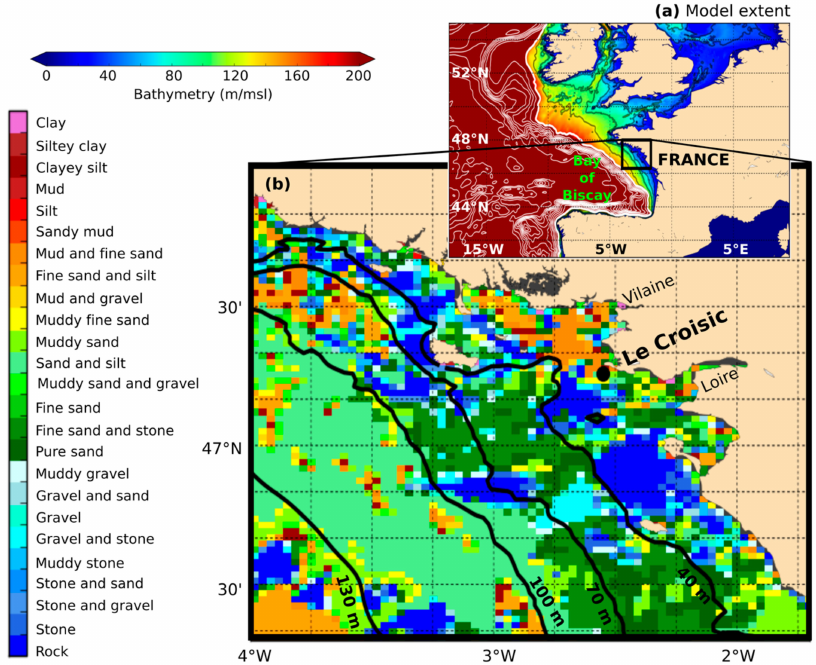
Figure 1. Geographic extent of the 3D model configuration with its bathymetry (in meters with respect to mean sea level) ( a ). Initial condition for the seabed compartment (at the resolution of the model) ( b ), over the zone surrounding Le Croisic station (indicated by a black dot). In ( a ), the thickest white line represents the 180 m isobath, which can be considered as the external boundary of the continental shelf. In both subplots, black lines refer to the 40-m, 70-m, 100-m, and 130-m isobaths over the